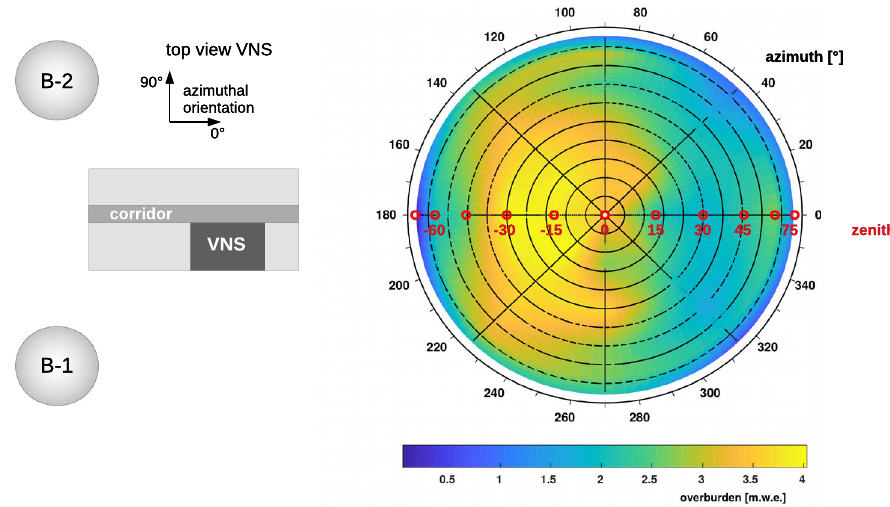
Fig. 4 Left: sketch of the office building hosting the VNS and the reactor buildings B-1 and B-2 as seen from the top. Right: overburden map over the VNS. The azimuth angle is measured counter-clockwise with respect to the direction opposite to the reactor buildings. The projections of the zenith angle are indicated by circles. The red markers represent the zenith angles in the measurements with 0 ◦ / 180 ◦ azimuthal